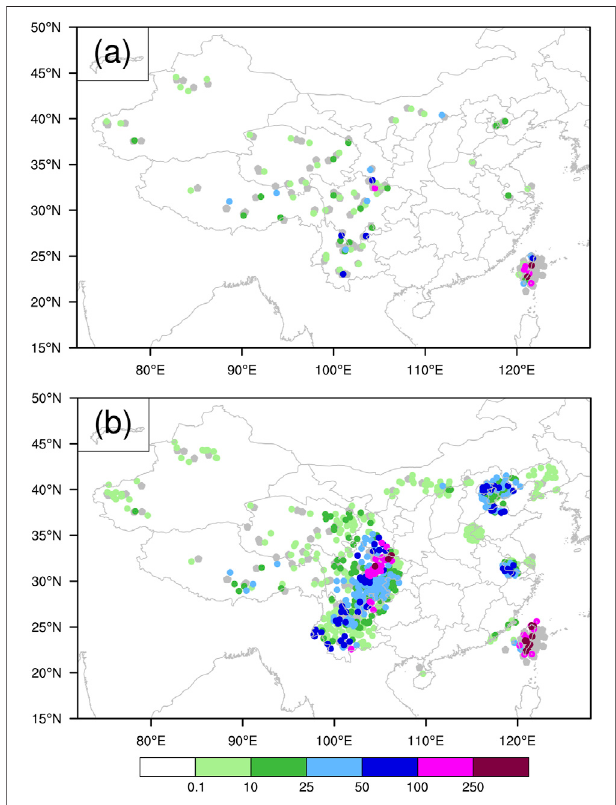
FIGURE 6 | Spatial distribution of strong earthquakes (gray dots) in China and the corresponding 5-day accumulated precipitation (colored dots, units: mm) in the in fl uential period (A) near the epicenter and (B) in the seismic area.